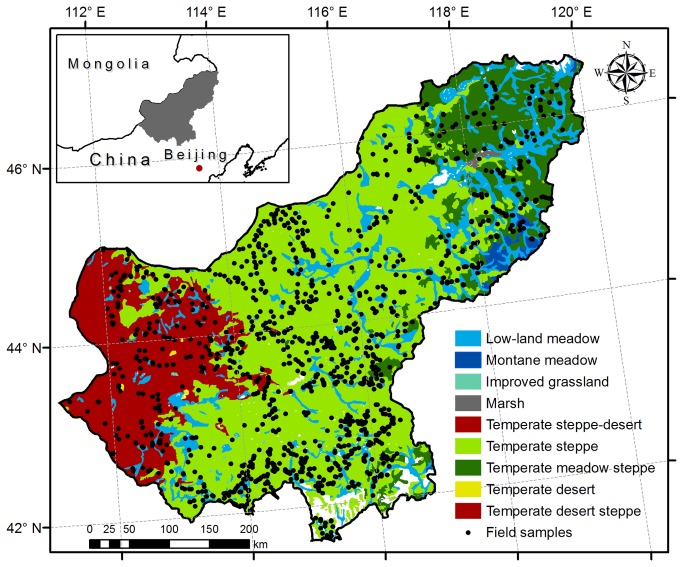
Locations of the 1,434 sampling sites across Xilingol on the background of a map of grassland types.